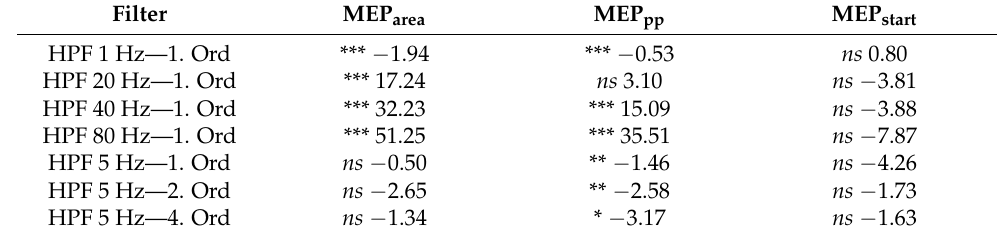
Table 1. In response to the different filter settings, the absolute percentage differences ( ∆ %) of the MEP-parameter between the raw data and the filtered signals are shown in the table. Significant differences in MEP characteristic parameters are presented. ns = not significant, * p < 0.05, ** p < 0.01, *** p < 0.001.